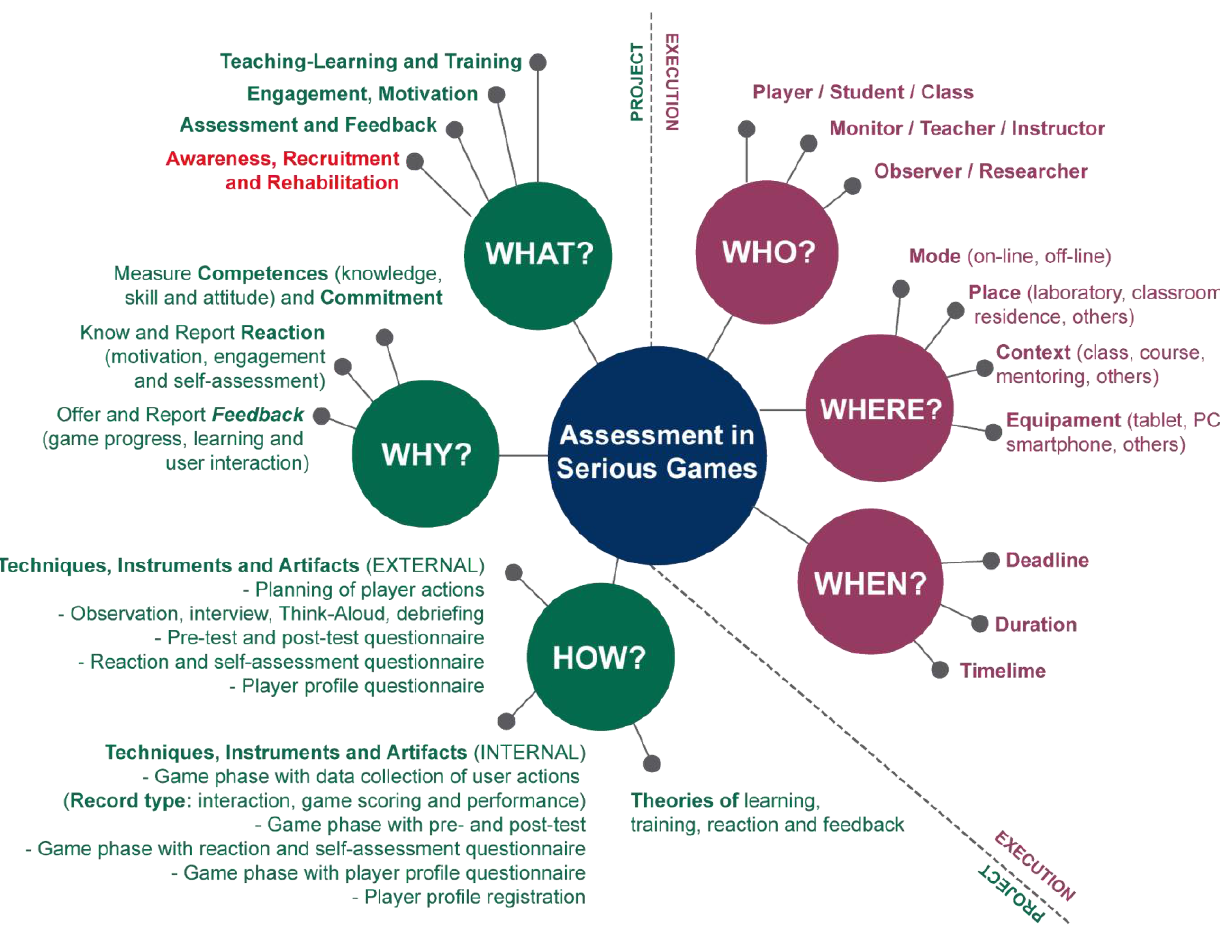
Figure 5. Summarized diagram of the canvas model content (in red, features not addressed by the